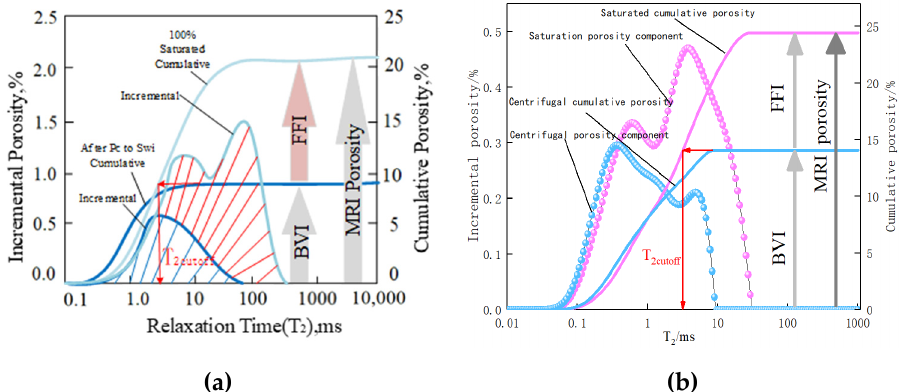
Figure 3. T 2 spectrum diagram of samples before and after centrifugation. ( a ) Theoretical distribution model; ( b ) Measured distribution model.